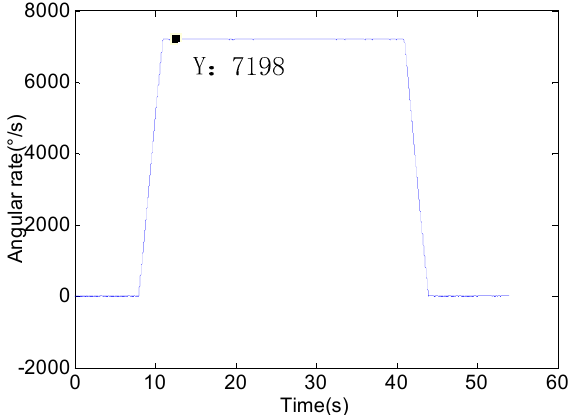
Figure 14. Feedback angular rate of flight simulation turntable.